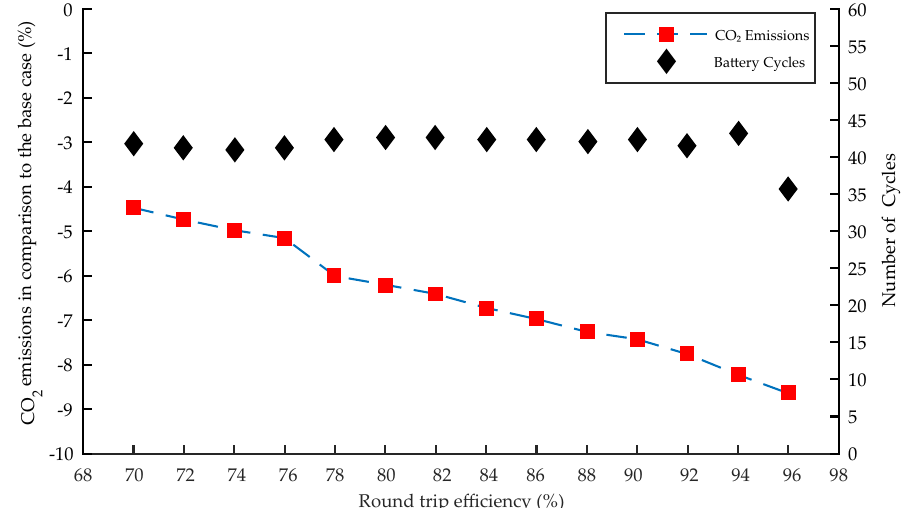
Figure 6. Changes in CO 2 emissions and number of cycles caused by a variation in the round trip efficiency. Battery power and capacity fixed at 1000 kW–1000 kWh. In red: CO 2 emissions reduction in the case of four diesel generators with batteries in comparison to the base case (four diesel generators and no batteries). In black: Number of battery